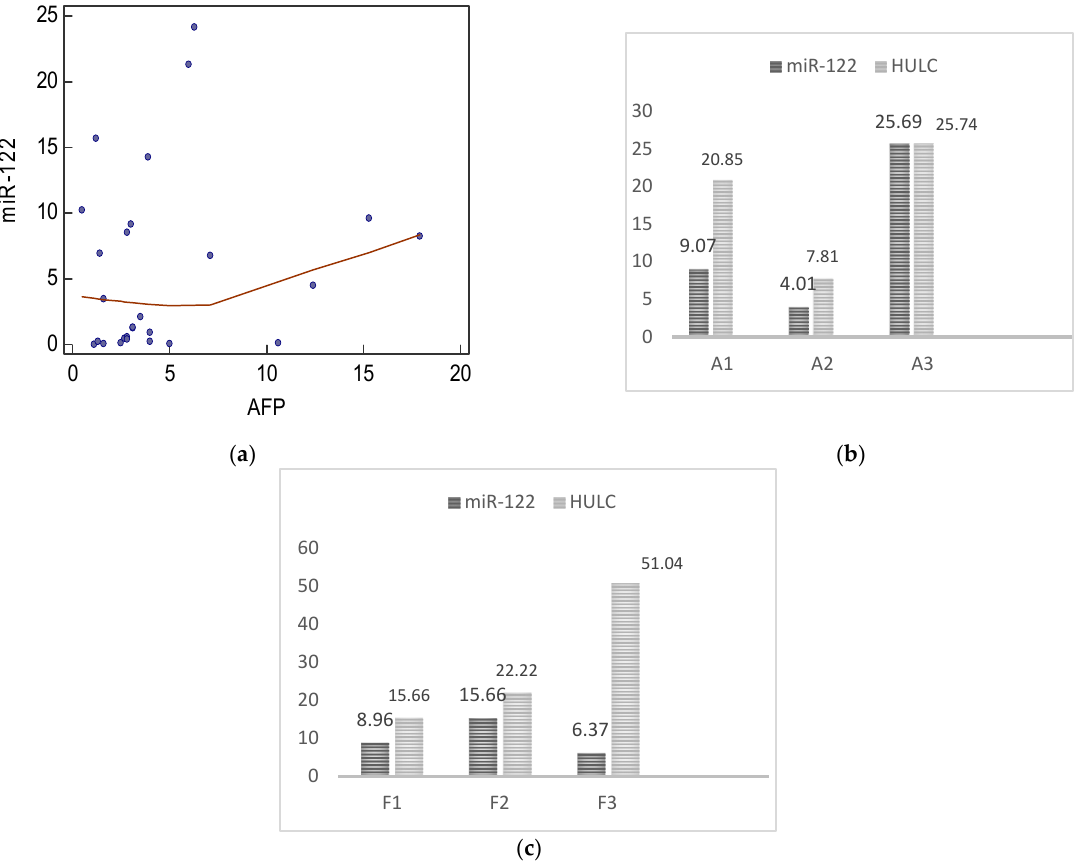
Figure 3. Correlation between gene expression of biomarkers and clinico-pathological findings in HCV patients. ( a ) correlation between miR-122 and AFP (r = 0.703, p = 0.001), r Pearson correlation, p value is statistically significant at p ≤ 0.05, ( b ) relation between serum biomarker expression levels and liver activity (A1, A2, and A3) among HCV patients, values are mean ± SE, miR-122 is signifi- cantly different between A1 and A3 ( p = 0.05) and between A2 and A3 ( p = 0.04), HULC is signifi- cantly different between A2 and A3 ( p = 0.05), and ( c ) relation between serum biomarker expression levels and the extent of liver fibrosis (F1, F2, and F3) among HCV patients, values are mean ± SE, p = 0.05 between F2 and F3 in measuring miR-122 and p = 0.03 between F2 and F3 in measuring HULC. The diagnostic value of miR-122 and HULC was determined by ROC curve analysis.